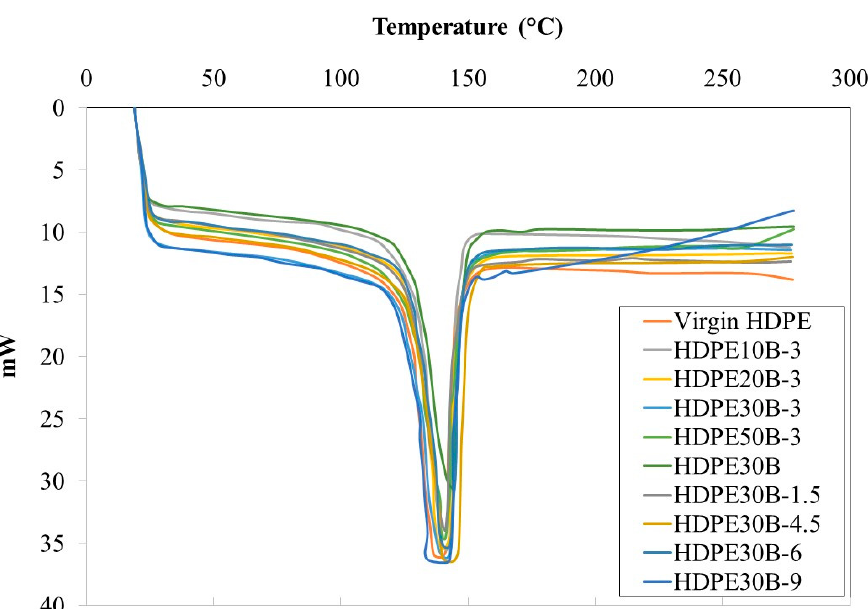
Figure 12. Melting temperature of HDPE/birch fiber composites, based on differential scanning calorimetry; the number preceding ‘B’ indicates the fiber concentration, the number following indicates the coupling agent concentration.